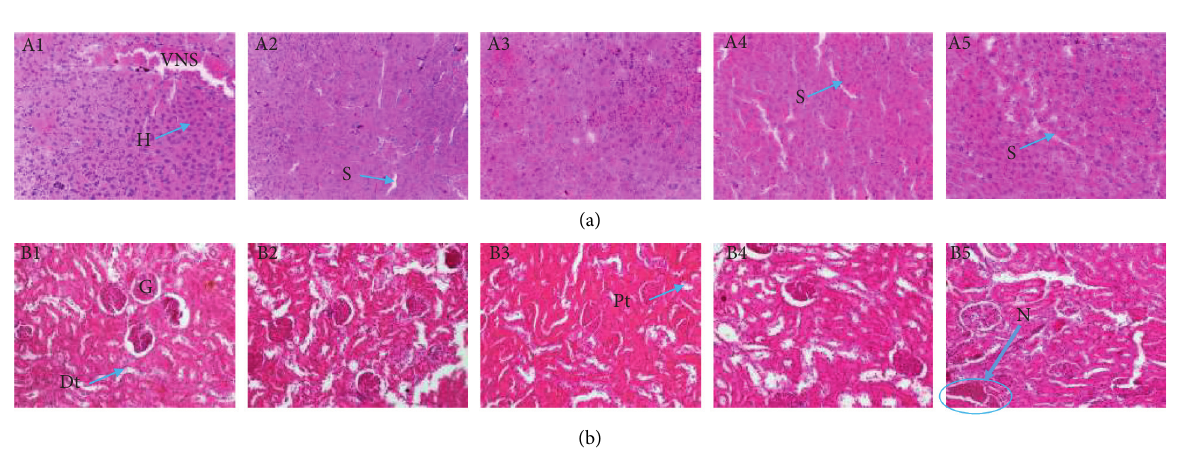
Figure 4: Effects of aqueous extract of T. grandis leaves on histological features of the liver (a) and kidney (b) in female rats (H&E × 400). A1, B1: control; A2, B2: 30mg/kg; A3, B3: 90mg/kg; A4, B4: 270mg/kg; A5, B5: 810mg/kg. G � glomerulus; N: necrosis; VNS: transected portal vein; S: sinusoids; H: hepatocytes; Pt: proximal tube; Dt: distal tube. The liver and kidney photomicrographs presented in the document represent the general appearance observed in at least three of the four animals in each